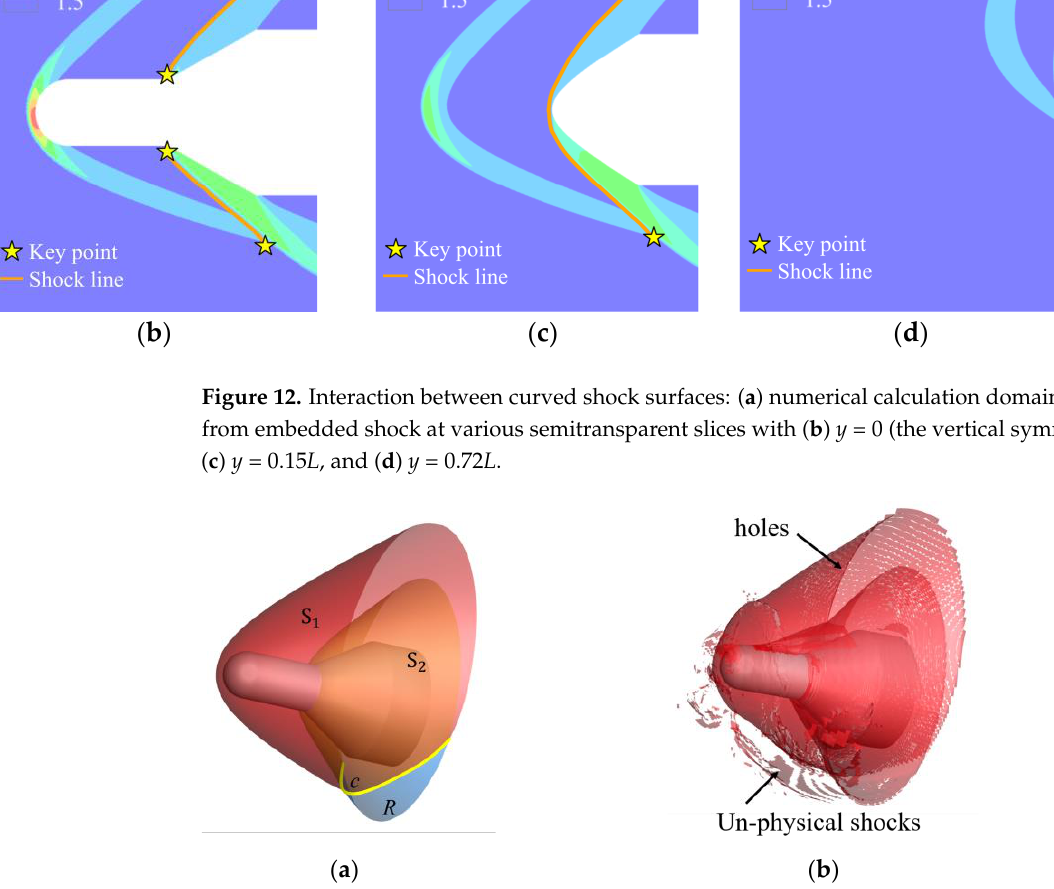
Figure 13. Shock waves are detected by ( a ) the method in this study and ( b ) the traditional method as a contrast.